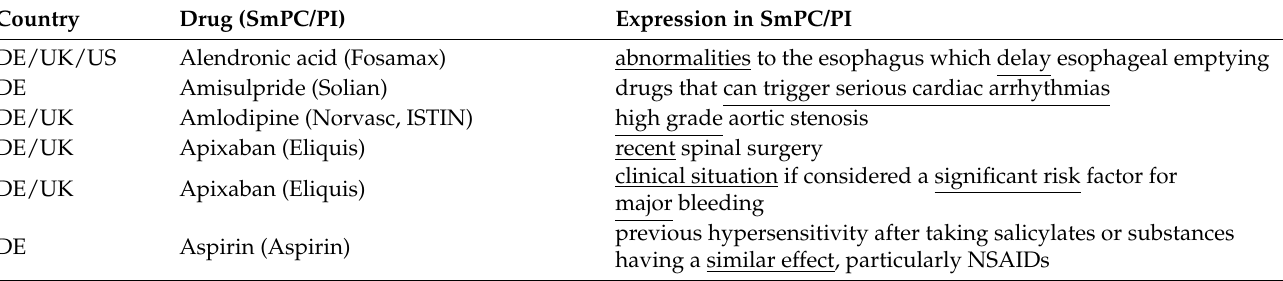
Table 1. Examples for problematic expressions in contraindications of SmPCs/PI that may leave too much room for interpretation or lack clear cut-off so that different prescribers may arrive at different conclusions as to whether the condition of a CI is fulfilled in a patient or not, or as to which internationally agreed reference lists are missing. Each ambiguous term is underlined.